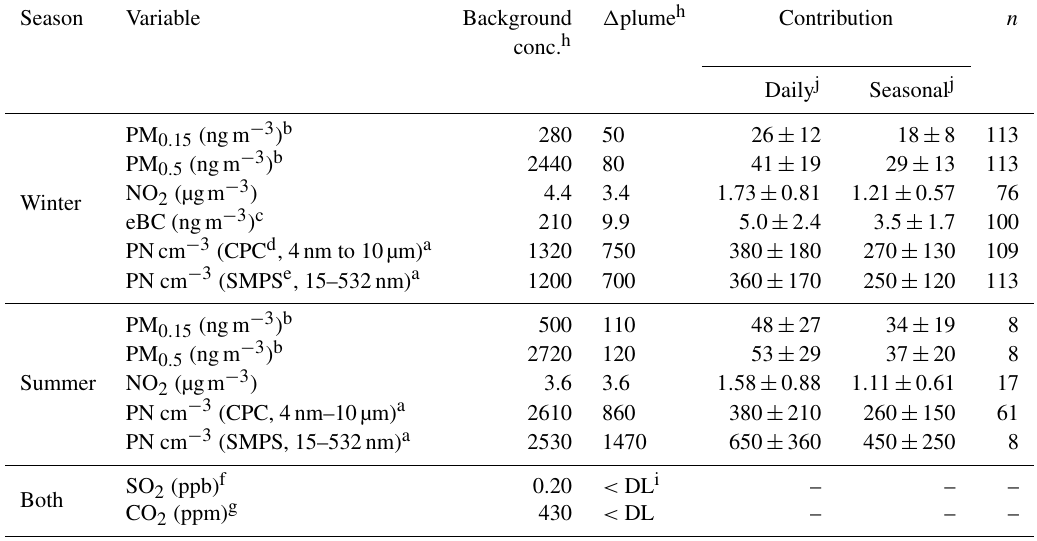
Table 1. Average absolute contribution of particle mass (PM), NO 2 , equivalent black carbon (eBC), particle number concentration (PN), SO 2 , and CO 2 to local air quality due to a number ( n) of ship plumes, from two measurement campaigns at the Falsterbo coastal